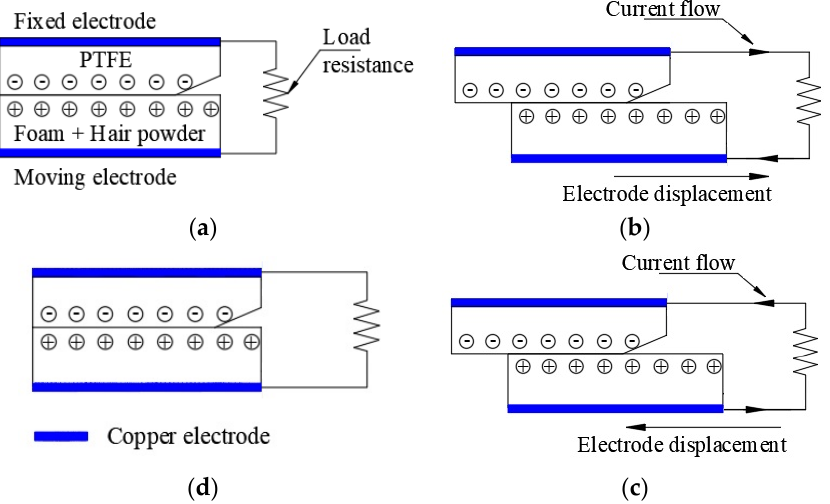
Figure 11. ( a ) Initial position of the electrodes; ( b ) outward displacement; ( c ) inward displacement; and ( d ) final position .